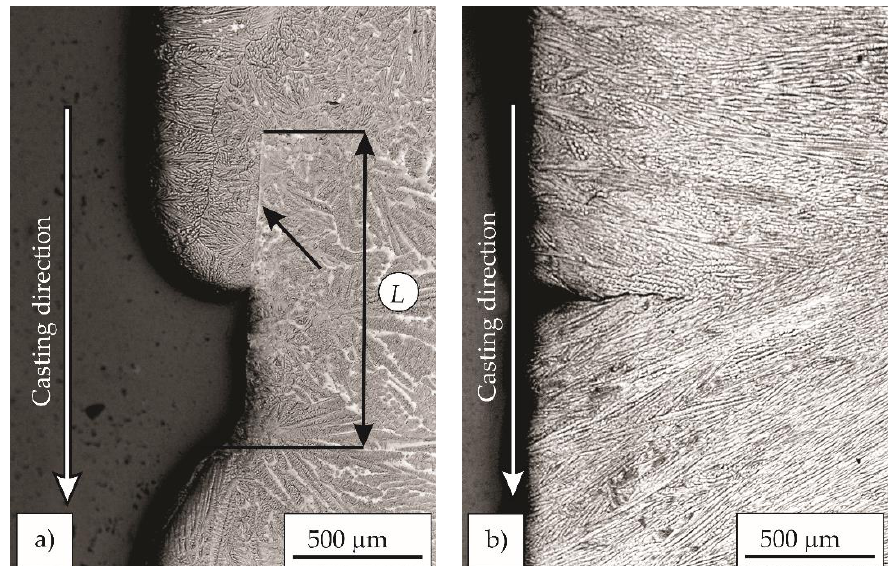
Figure 5. Strand 4: ( a ) Primary witness mark; the distance L marks the approximate length of the solid skin formed when the solidification front protruded into the nozzle. Upon the following stroke, this skin remained solid in spite of being covered with melt (indicated by the arrow). ( b ) Crack on a secondary witness mark.